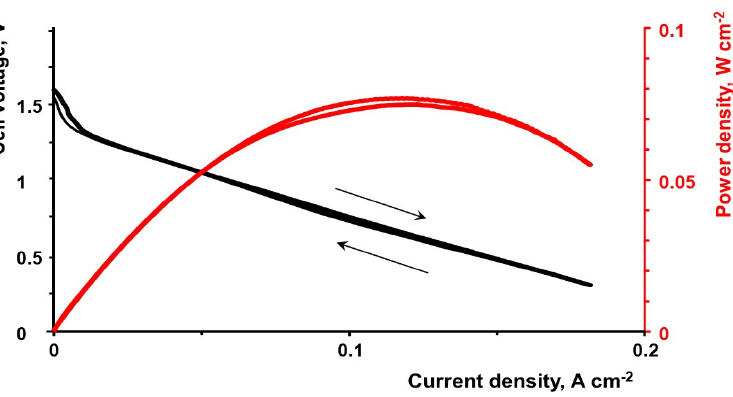
Figure 3. Performance of the Al/KIO 3 single cell at 30 °C. The rates of the catholyte and anolyte supply were similar to those of the Al/NaBrO 3 cell in Figure 1.